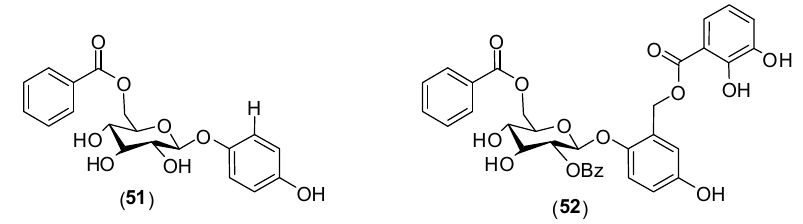
Figure 21. Phenolic glycosides 51 and 52 .